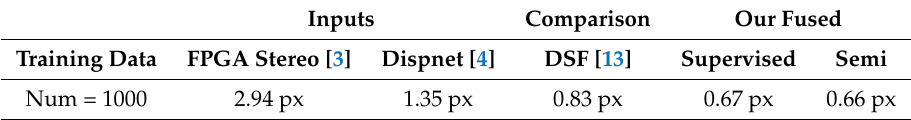
Mean absolute disparity error of stereo-stereo fusion on Trimbot Garden Dataset (270 test